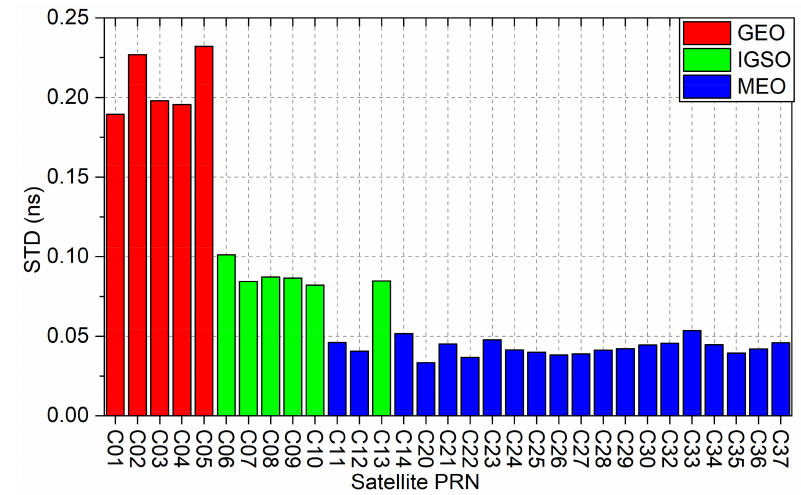
Figure 3. Average STD of the real-time estimated BDS-2/BDS-3 satellite